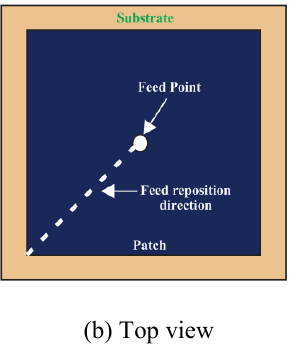
Figure 2. Conventional structures of the proposed antenna.